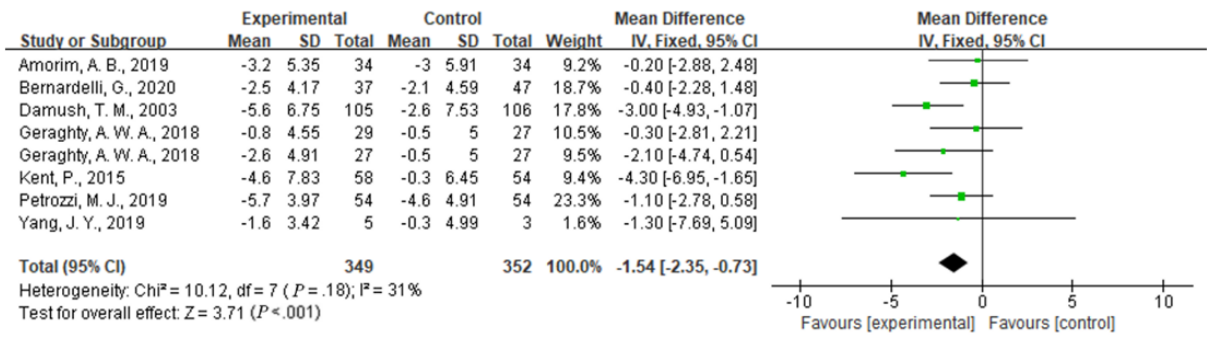
Figure 4. Forest plot of the efficacy of mobile health and traditional health interventions on disability.